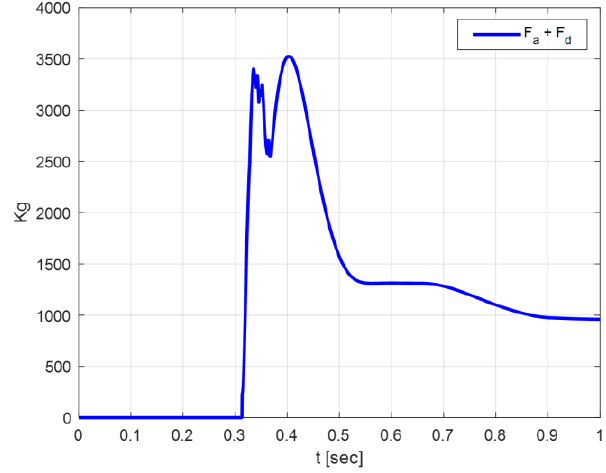
Figure 10. Time history of shock absorber total force ( F a + F d ).